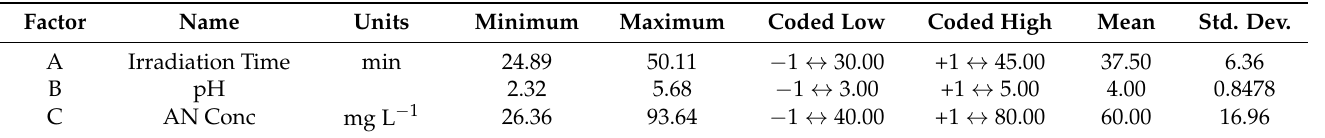
Table 1. Actual actors affecting the photocatalytic degradation of AN by CuO/Alg-Agar BNC and their